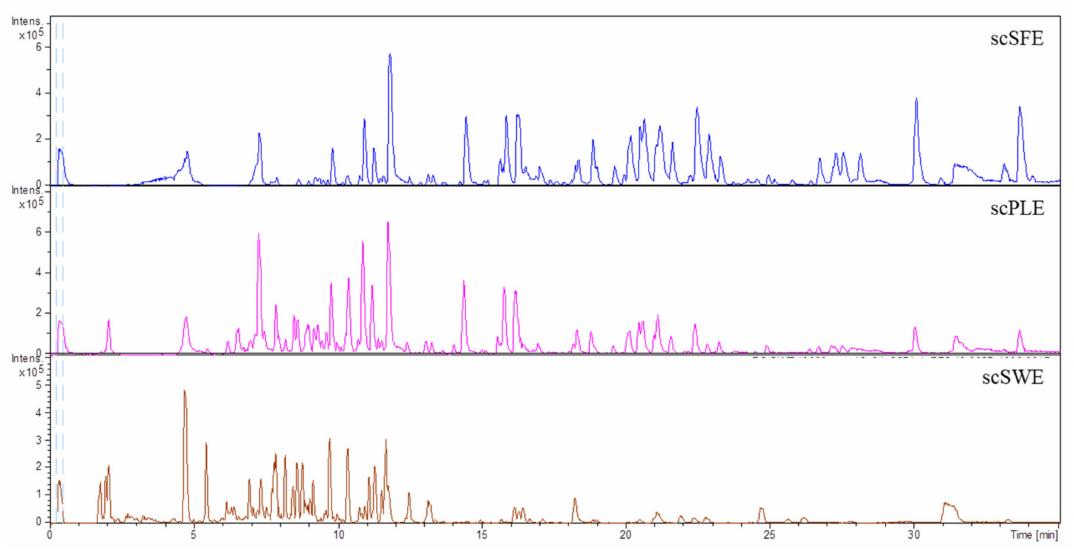
Figure 1. Base peak chromatograms of the extracts from SC stems obtained by supercritical fluid extraction (SFE; scSFE), pressurized solvent extraction (PLE; scPLE), and subcritical water extraction (SWE; scSWE). Table 1. Analytical data obtained from high-performance liquid chromatography coupled to